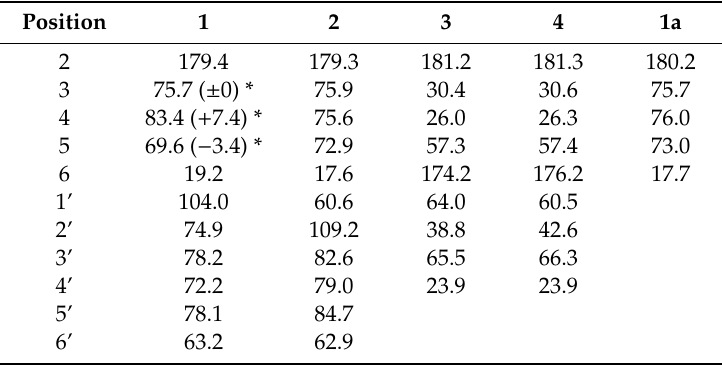
Table 2. 13 C-NMR spectroscopic data for compounds 1 – 4.